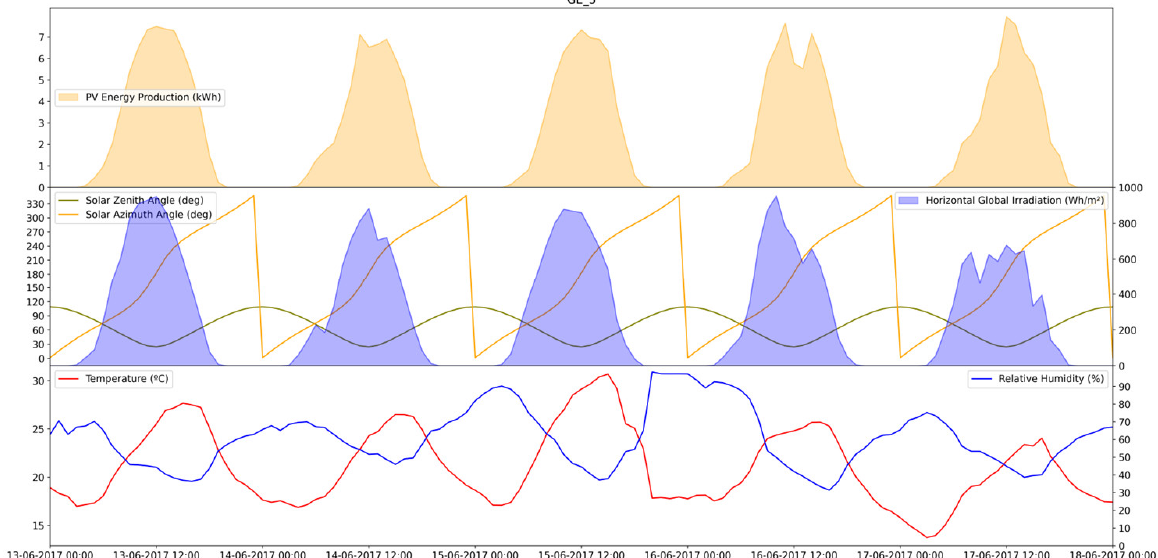
Figure 3. Photovoltaic (PV) energy production (kWh), horizontal global irradiation (Wh/m 2 ), solar zenith (°), solar azimuth (°), temperature (°C), and relative humidity (%) from one of the PV facilities in Germany (GE_3) during five days.